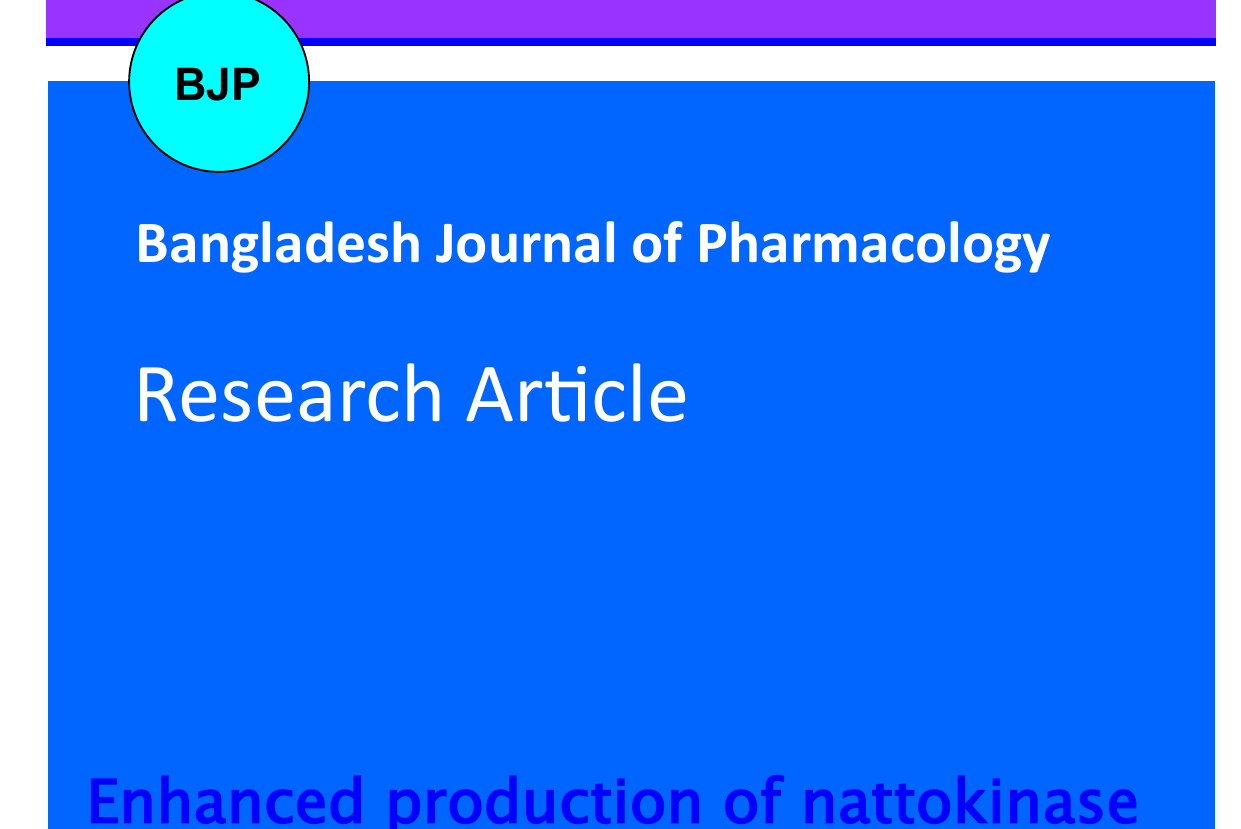
Enhanced production of nattokinase from UV mutated Bacillus